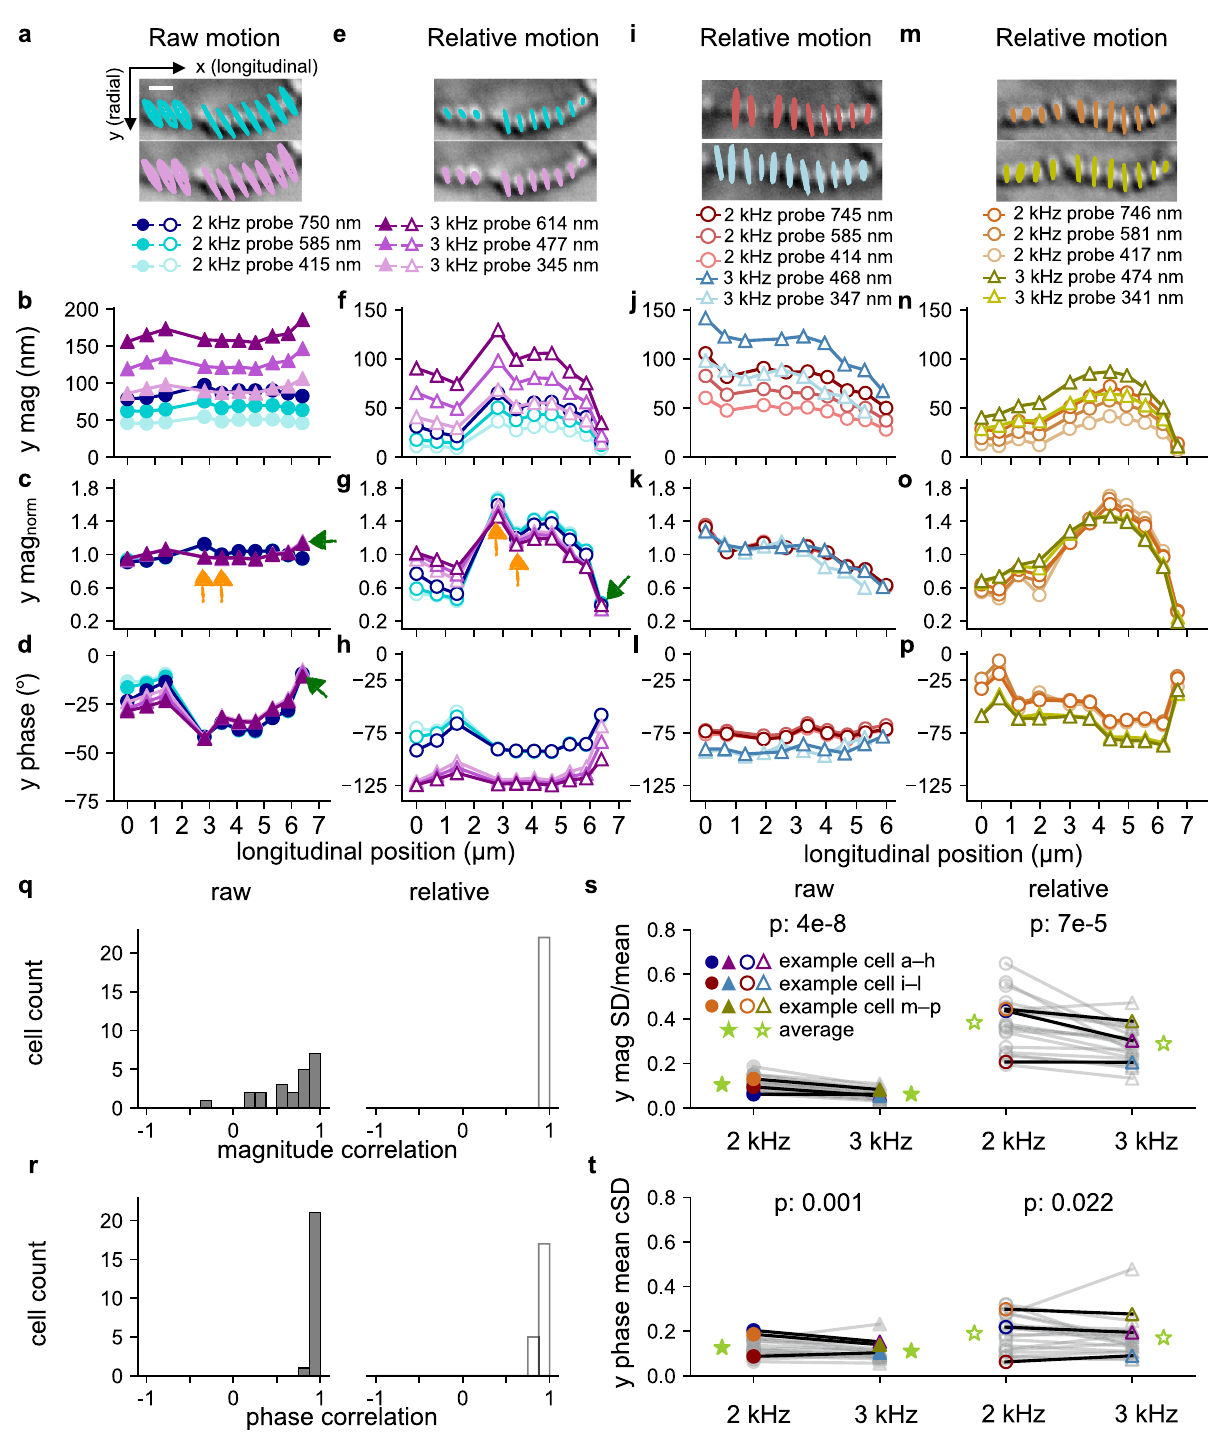
while the phase relationships stay the same (see example in Fig. 4a, c). For the control dish-stimulation experiment, the raw motion follows the apical-surface motion, i.e., they have the same magnitude (average magnitude ratio = 0.99 ± 0.04; Fig. 4b) and a close-to-zero phase difference ( − 1.5° ± 3°; Fig. 4d) across all cells. As a result, the relative motion is close to zero at all levels (magnitude ratio = 0.07 ± 0.04; Fig. 4b), which is expected for rigid-body motion of the whole cochlea. For stapes stimulation (Fig. 4b), the raw-motion magnitudes (Fig. 4b left panel) are greater than the apical-surface magnitude (ratios of 1.39 ±